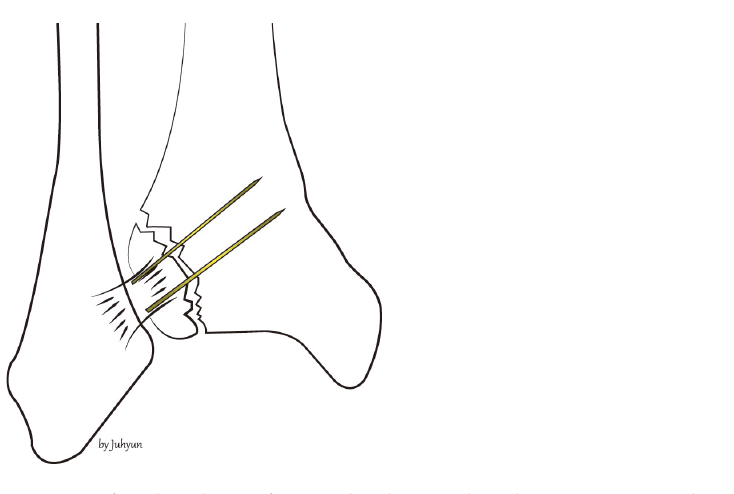
Figure 1. If a fibular fracture is also present, we take a curved anterolateral approach (dotted line). In the absence of such a fracture, a small anterolateral incision (about 2–3 cm) is created (solid line) directly over the palpable Chaput tubercle of the distal tibia.